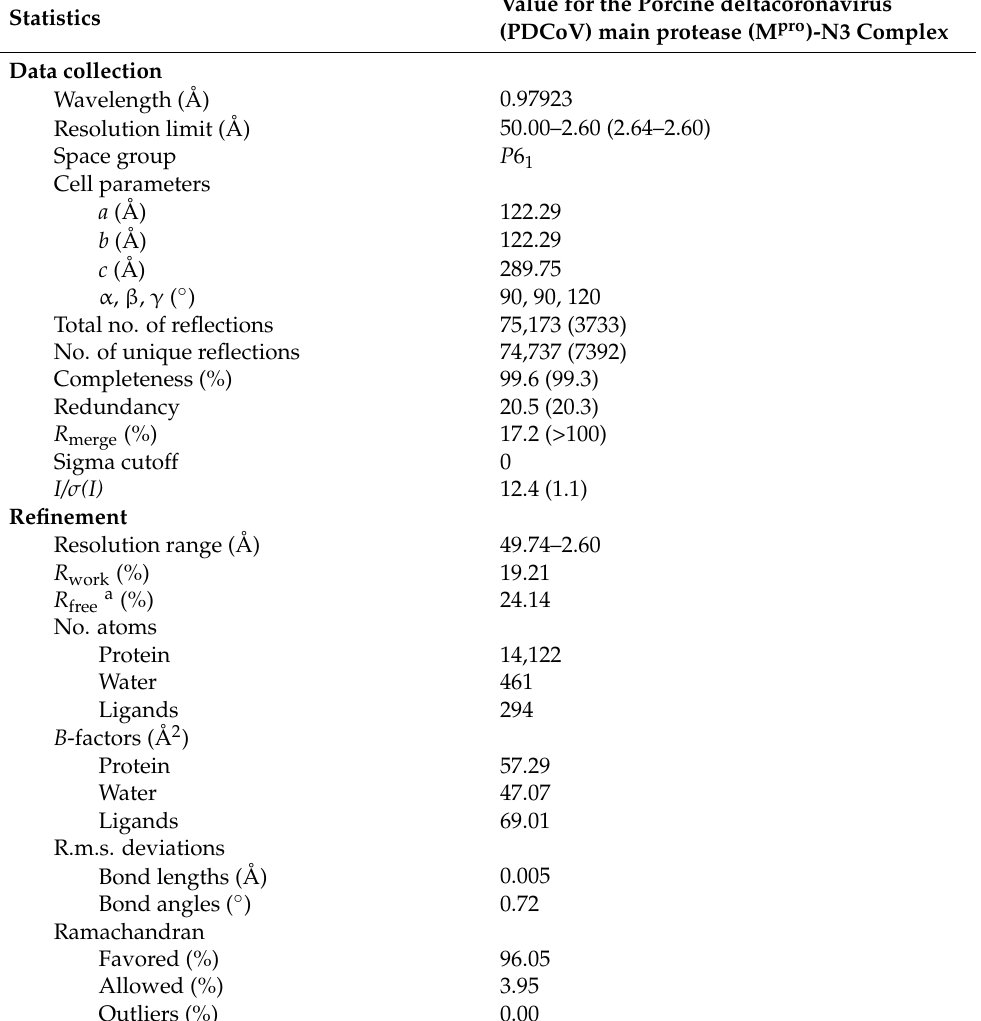
Table 1. X-ray data-processing and refinement